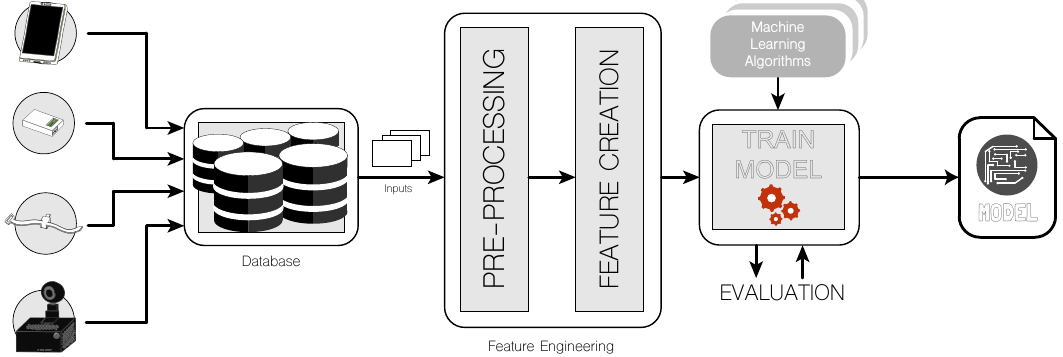
Figure 1. General concept of the proposed